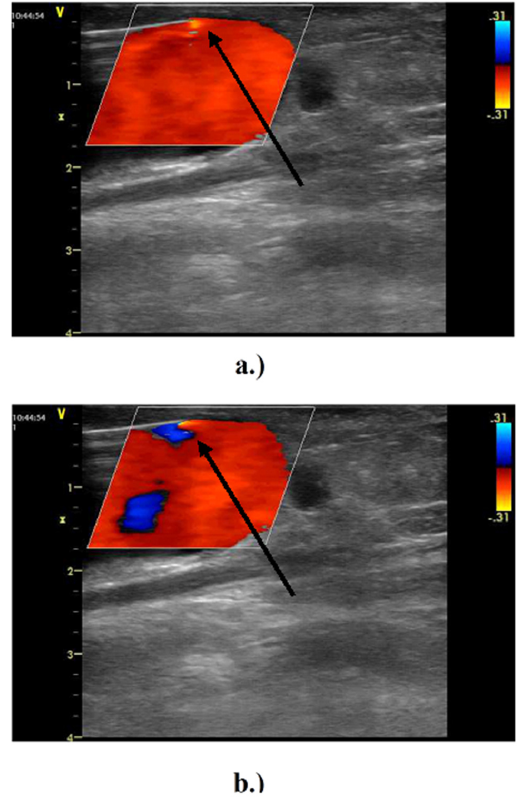
Figure 3. In vivo measurement of arterial needle blood flow during hemodialysis using Doppler ultrasound. Ipsilateral brachial artery blood flow was 1120 ± 362 mL/min and extracorporeal flow volume was set to 250–300 mL/min. Outflow vein diameter in the area of the punctures was 11 ± 3 mm. The prevailing direction of the flow (suction) at the needle tip (arrow) is highlighted using a lighter red color. ( a , b ) Flow reversal inside the vascular access at the suction needle due to the peristaltic pump action (small blue area, arrow).